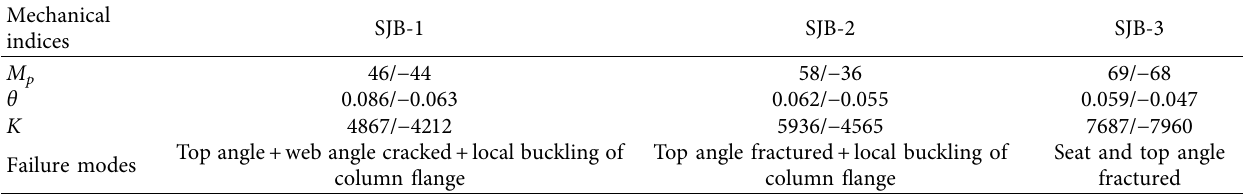
Table 3: Hysteresis test results.